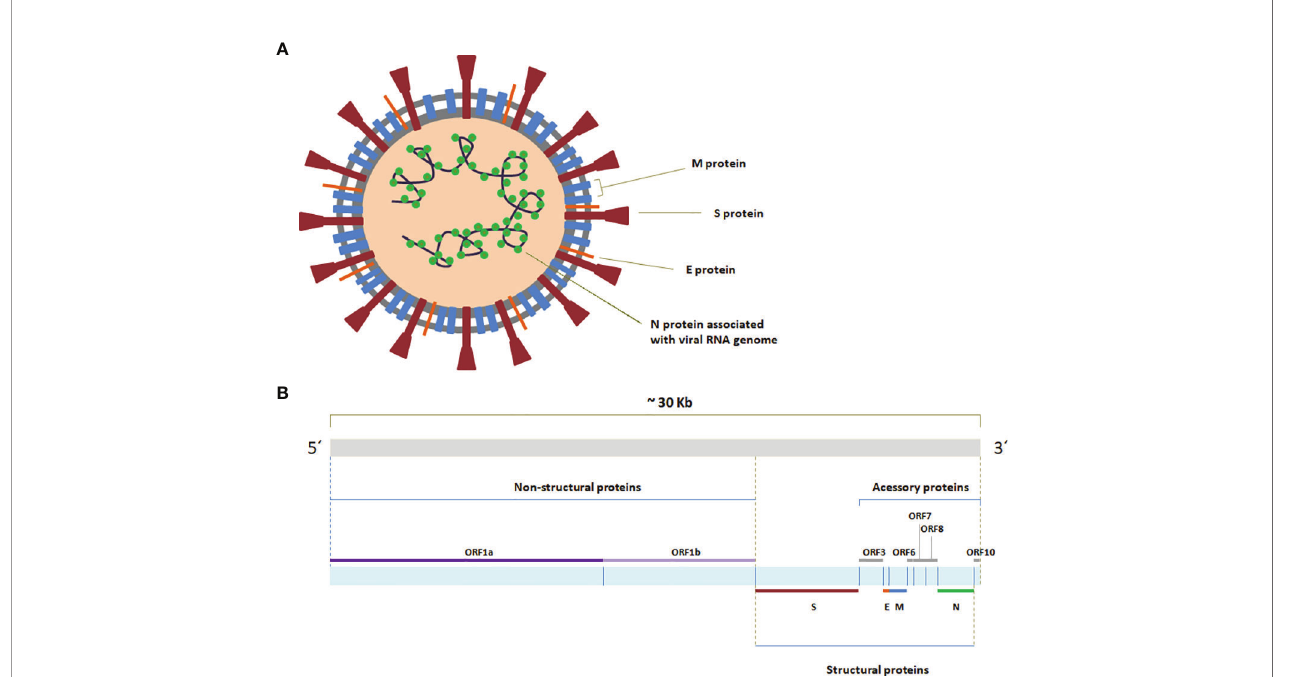
FIGURE 2 | (A) Genome organization of SARS-CoV-2. The ORFs constituting the SARS-CoV-2 RNA genome (from 5´ to 3´) encode the non-structural proteins (NSPs), which originate from ORF1a and ORF1b (ORF1ab), the spike (S), envelope (E), membrane(M) and nucleocapsid(N), as well as more than a handful of other dispersed and not-fully characterized accessory proteins (Kim et al., 2020; Hu et al., 2021). The ORFs that lead to accessory proteins include mainly ORF3, ORF6, ORF7, ORF8 and ORF10 (Michel et al., 2020; Giri et al., 2021). (B) Schematic representation of SARS-CoV-2